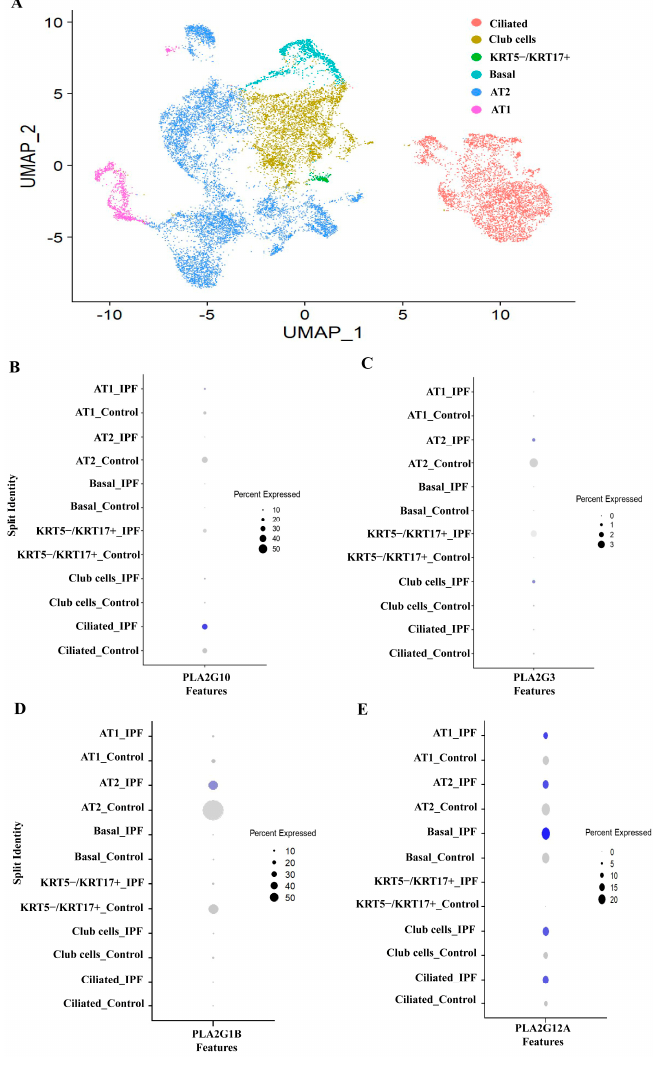
Figure 5. Analyzing expression of PLA2G10 and PLA2G3 in epithelial cells ( A ) UMAP showing the distribution of various clusters of epithelial cells. ( B – E ) Dot plot visualization of expression of PLA2G10, PLA2G3, PLA2G1B and PLA2G12A in epithelial cells from Control and IPF patients. IPF patients as compared to healthy individuals (Figure 6A).